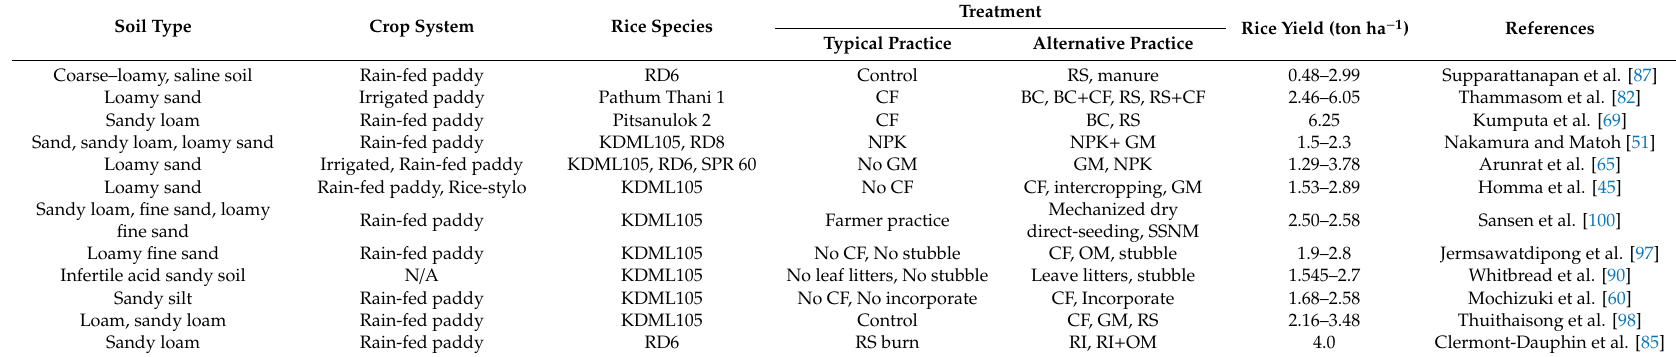
Table 3. Rice yield and alternative management practice of rice-based cropping under sandy soil conditions of Northeast